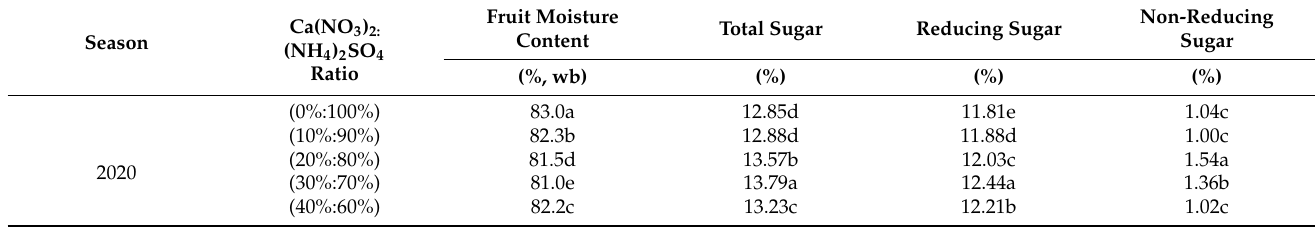
Table 5. Impact of Ca(NO 3 ) 2: (NH 4 ) 2 SO 4 ratios on moisture content, total reducing, and